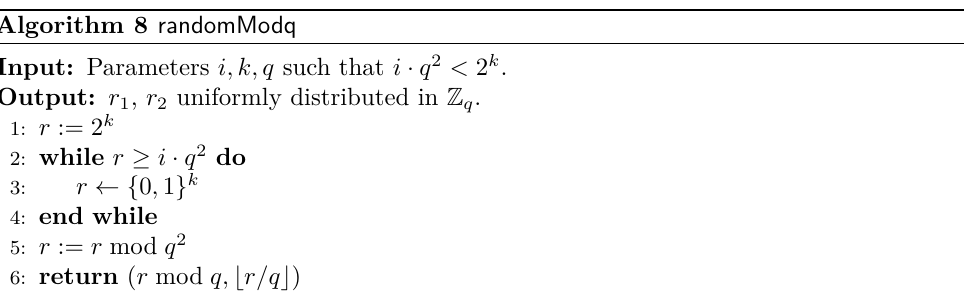
Algorithm 8 randomModq